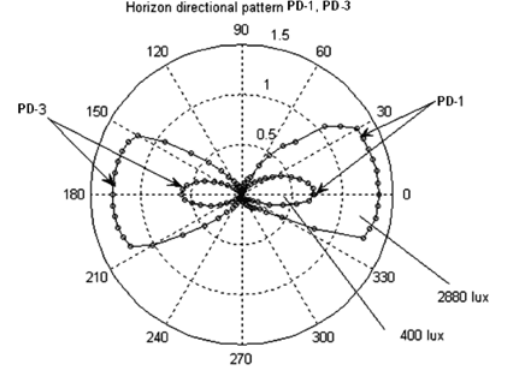
Fig. 7. Horizontal directional diagrams of PD-1, PD-3